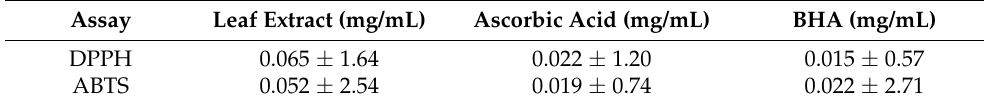
Table 2. IC 50 values of the leaf extract, ascorbic acid and